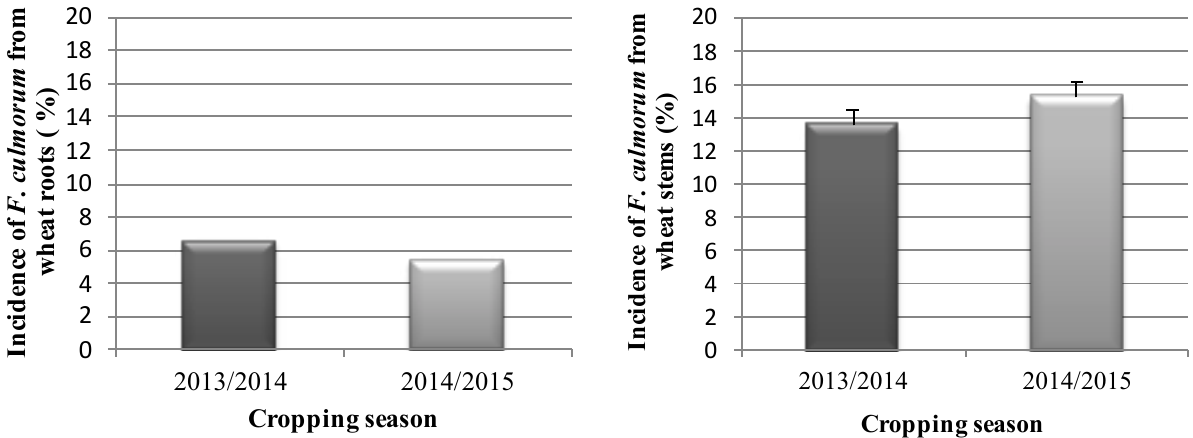
Figure 3. Mean incidence of Fusarium culmorum isolations from durum wheat roots (A) and stem bases (B) during two cropping seasons, at the Bou Salem,Tunisia, field trial. Error bars are 2 × standard deviations.